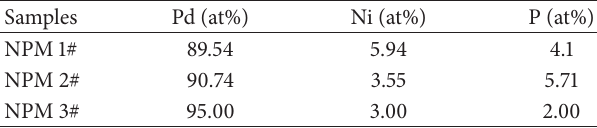
Table 1: Chemical compositions of the as-obtained NPMs.